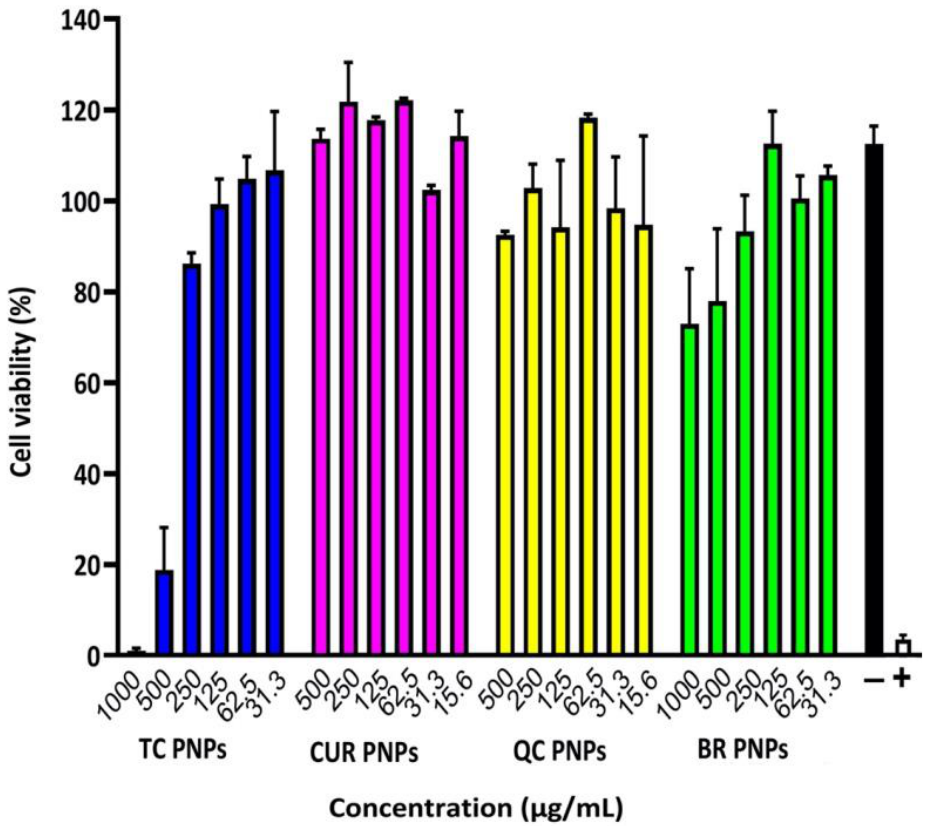
Figure 5. Resazurin cell viability assay for HEK-293 cells in the presence of different concentrations of SrtAI-loaded (TC, CUR, QC, and BR) PNPs at 24 h. The data are expressed as the mean percent cell viability ± SD ( n = 3). The positive control (+) consisted of 10% ( v / v ) SDS, 0.1 M HCl, while the negative control ( − ) consisted of cells treated with complete media containing 0.01% ( v / v ) DMSO.